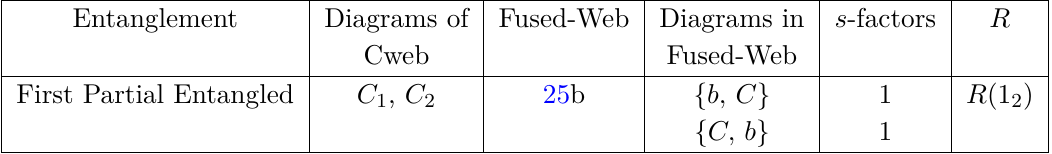
Table 12. Fused-Webs and their mixing matrices for Cweb W (2 , 1)